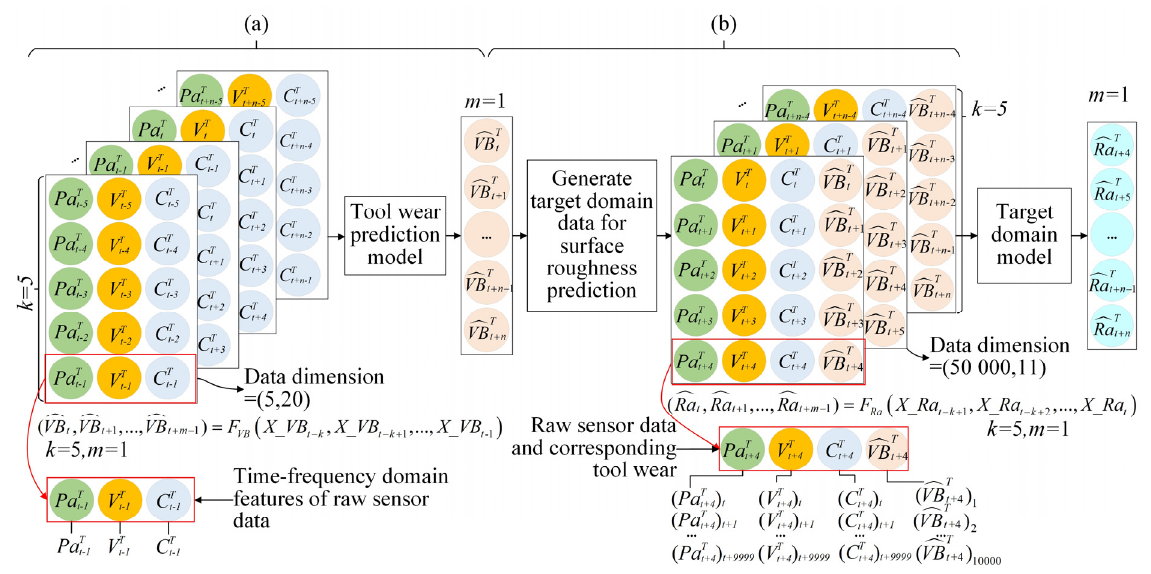
Figure 8. Data preparation for surface roughness prediction: ( a ) Tool wear prediction process in the target domain; ( b ) data generation process for roughness prediction integrating tool wear in the target